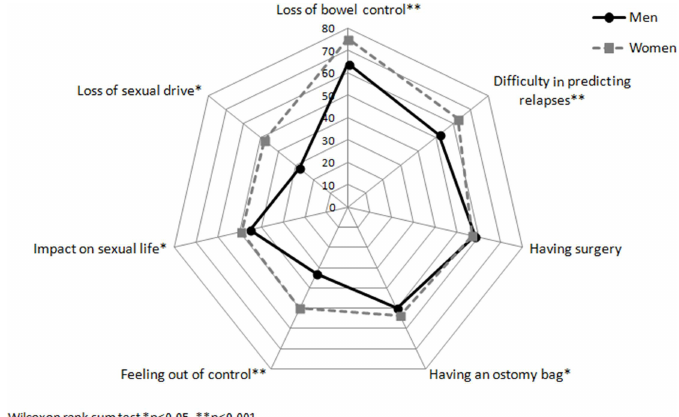
Fig 3. Median for individual concerns related to loss of body control according to